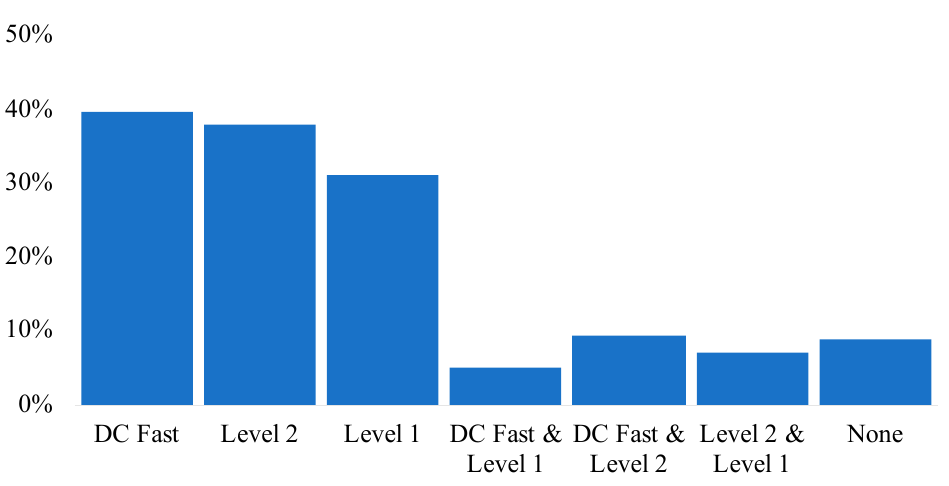
Figure 12. Distribution of mean charging levels for seven driver clusters.